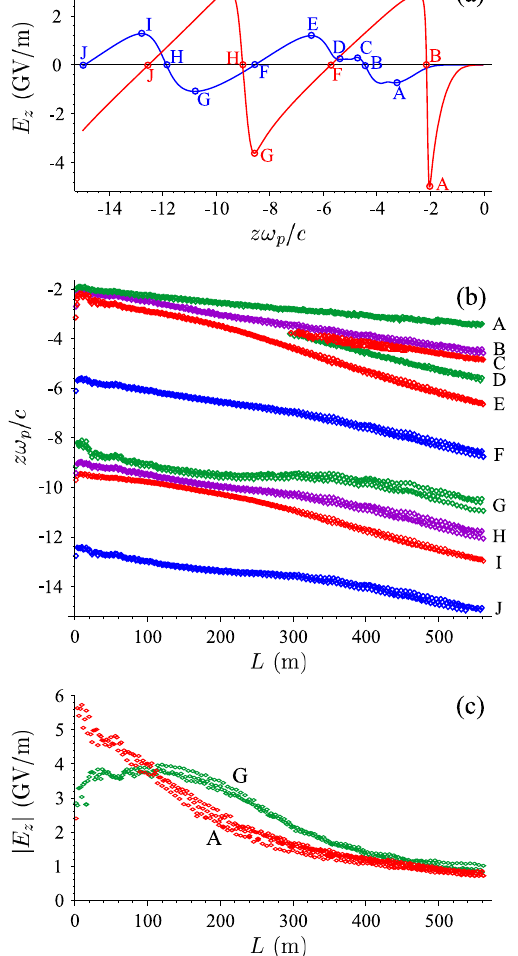
FIG. 6. (Color) (a) The unloaded on-axis electric field generated by a fresh driver ( L ¼ 30 m , red) and by a depleted one ( L ¼ 540 m , blue); (b) locations of field extrema and zeros as func- tions of the traveled distance [letters correspond to the points marked in (a) by circles]; (c) field amplitude in the first two local minima. The plasma density here is constant: n 0 ¼ 10 15 cm (cid:1) 3